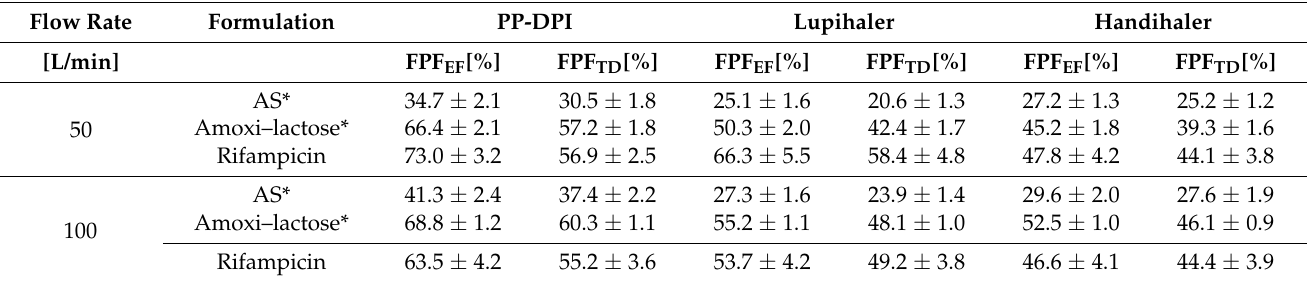
Figure 3. Scanning electron microscopy (SEM) images of the different formulations in different magnifications. ( A , B ) Cyclocaps [albuterol sulfate—lactose blend]; ( C ) amoxicillin; ( D ) amoxicillin– lactose blend; ( E , F ) rifampicin. Table 1. Fine particle fraction of the emitted (FPF EF ) or total dose (FPF TD ) for the different formula- tions (AS* = albuterol sulfate–actose binary blend; amoxi–lactose blend* = amoxicillin–lactose blend; rifampicin) tested with various